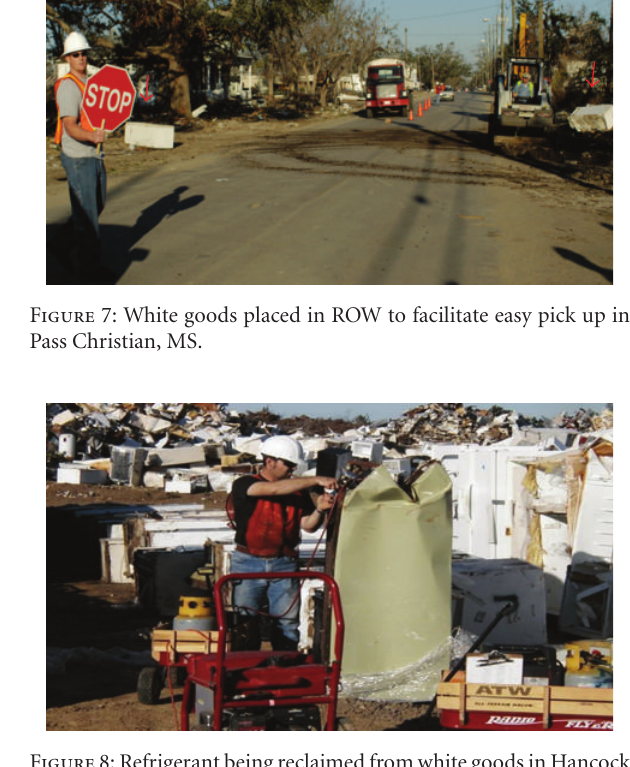
Figure 6: Concrete segregated at the Firetower TDSRS in Harrison County, MS.